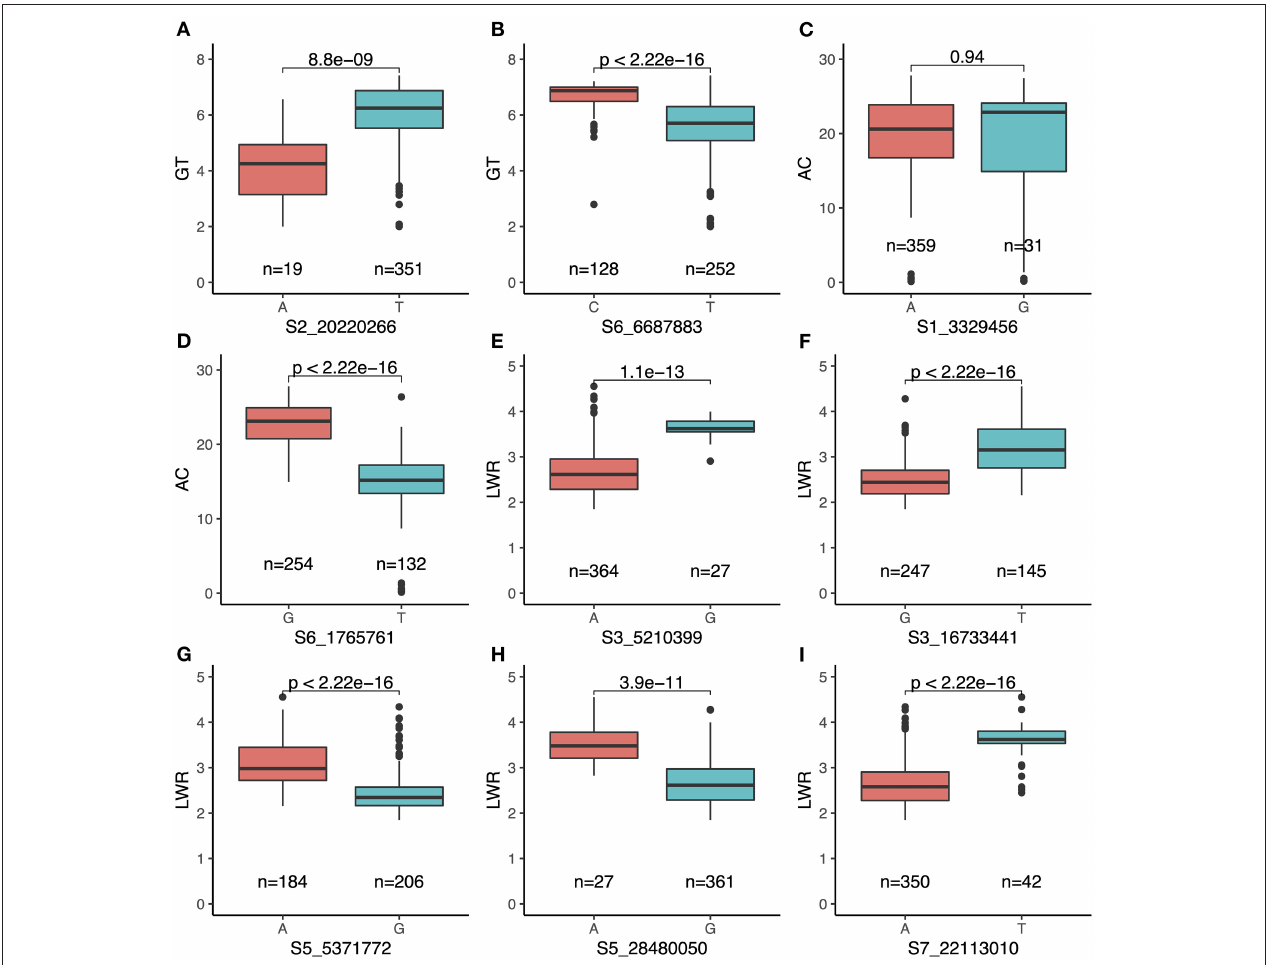
FIGURE 6 | Comparison of nine QTLs simultaneously identified by both MLM and BLINK carrying major and minor alleles of each SNP associated with the traits. (A) qGT2-1 and (B) qGT6-2 for GT; (C) qAC1-2 and (D) qAC6-1 for AC; (E) qLWR3-1 , (F) qLWR3-2 , (G) qLWR5-1 , (H) qLWR5-2 , and (I) qLWR7-2 for LWR.